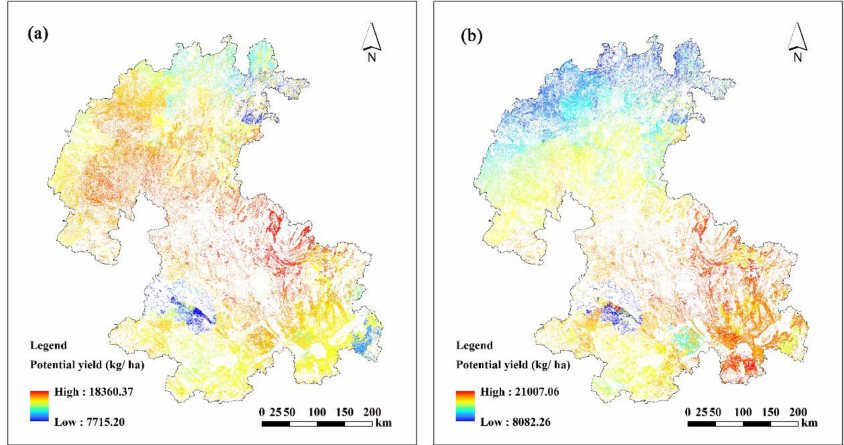
Figure 5. ( a ) The mixed potential grain yield derived from NPP in 2000; and, ( b ) The mixed potential grain yield derived from NPP in